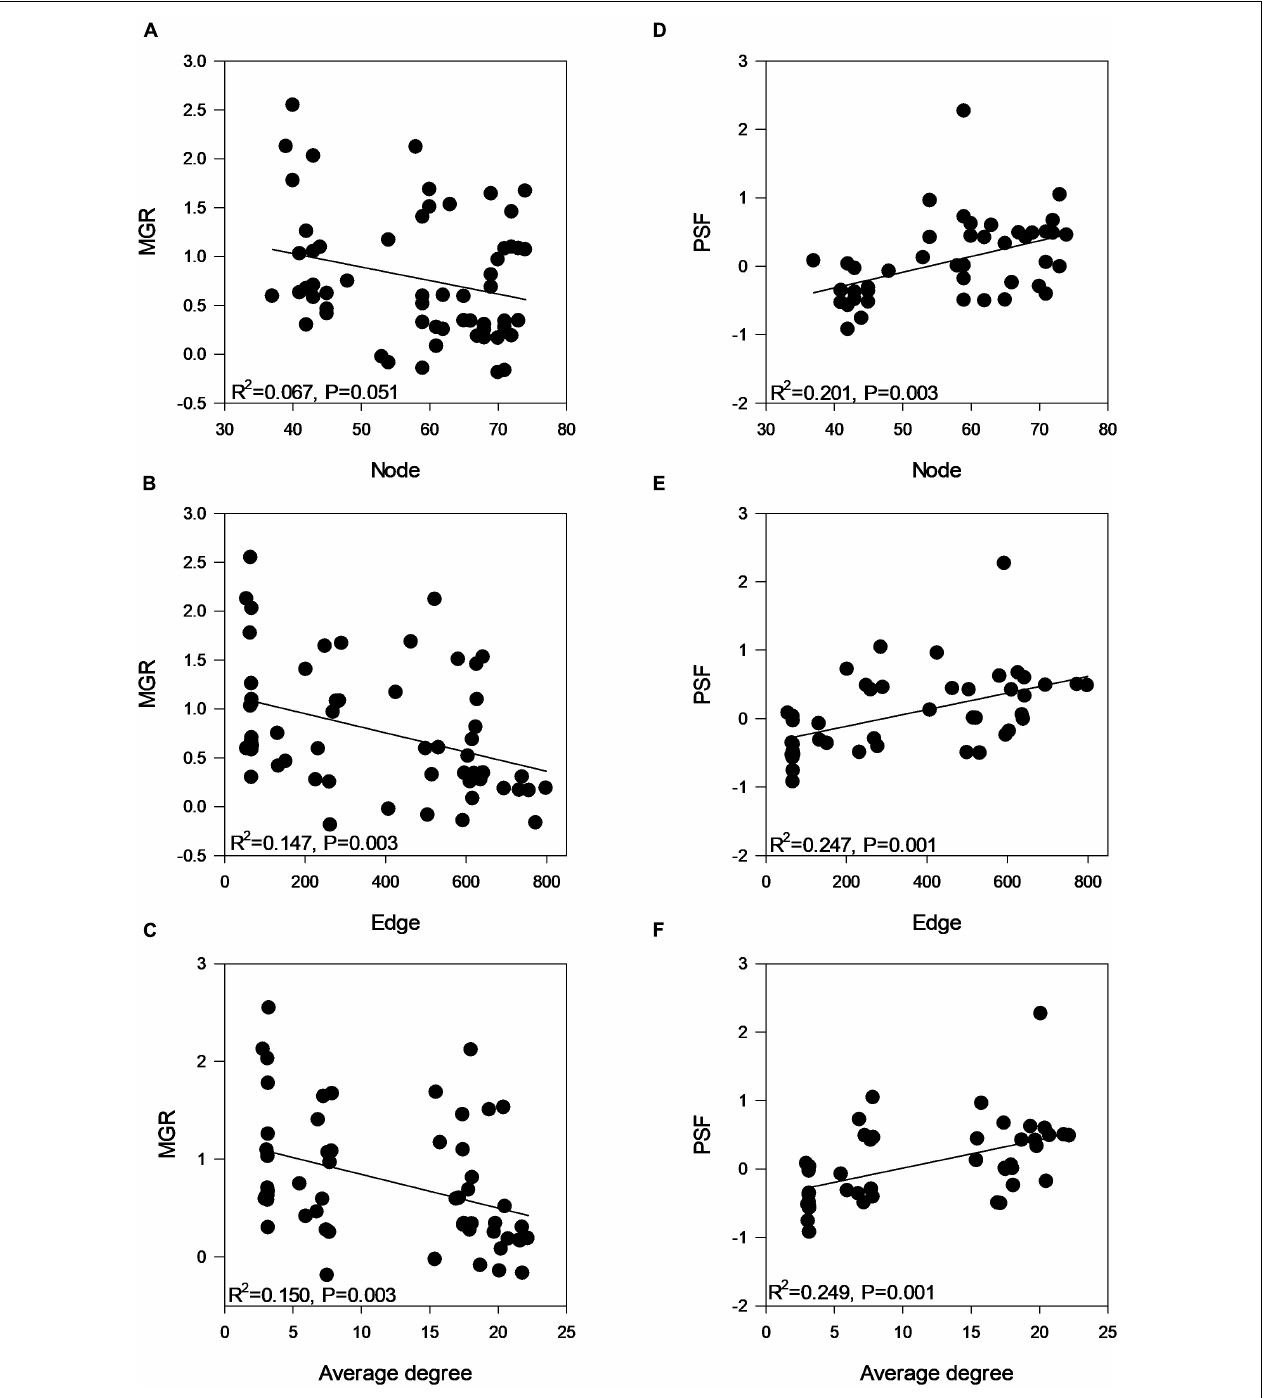
FIGURE 5 | Linear regression analysis between (A–C) plant MGR and rhizosphere AMF network properties and (D–F) plant PSF and rhizosphere AMF network properties indicating the network complexity (number of nodes, edges, and average degree). Significant negative/positive relationships between network complexity and MGR/PSF were